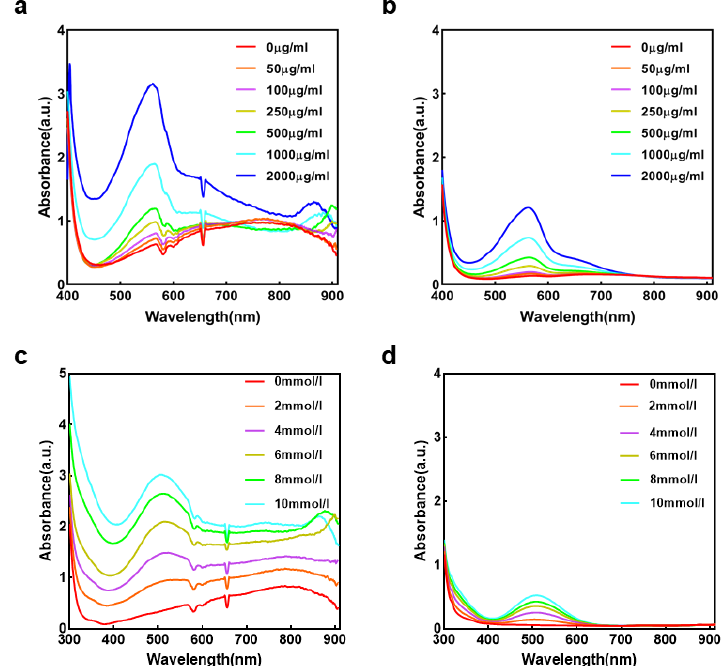
Figure 4. Spectral measurement using the AHTEMR and CMR: ( a ) Absorbance spectrum of BSA at different concentrations measured by the AHTEMR. ( b ) Absorbance spectrum of BSA at different concentrations measured by the CMR. ( c ) Absorbance spectrum of glucose at different concentrations measured by the AHTEMR. ( d ) Absorbance spectrum of glucose at different concentrations measured by the CMR.